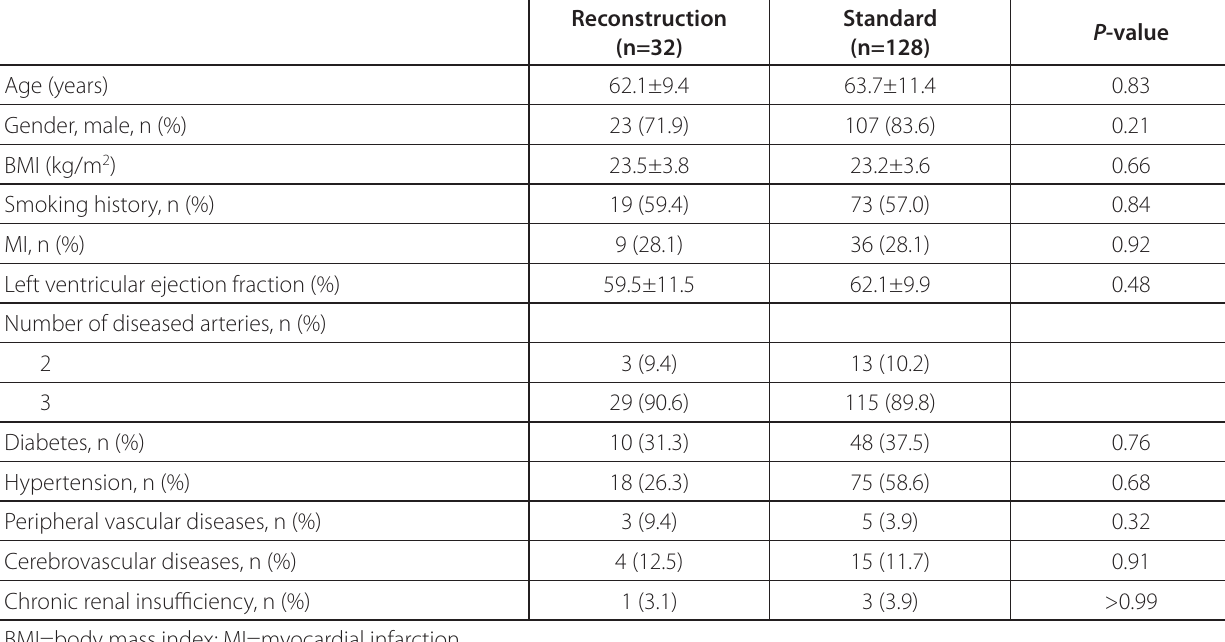
Table 1 . Comparison of preoperative data.